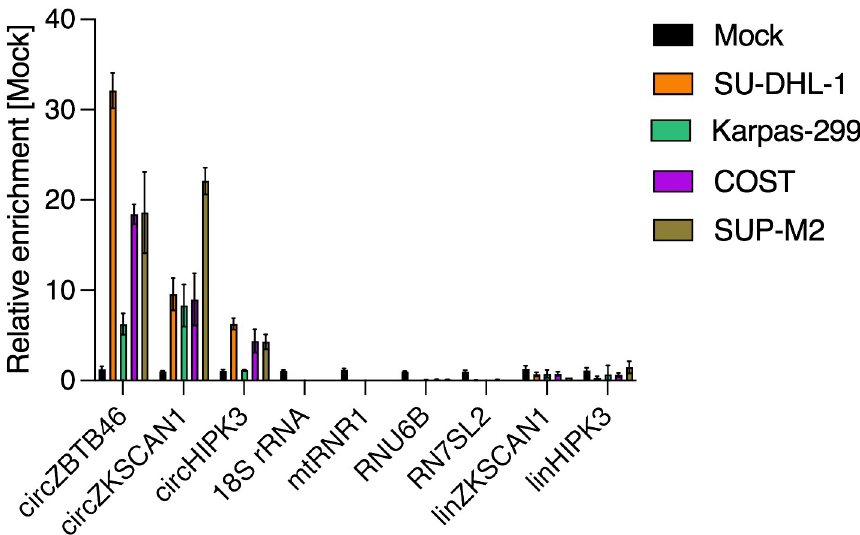
Fig 2. circRNAs get enriched by the library workflow. 4 different RNA samples from anaplastic large-cell lymphoma cell lines (SU-DHL-1, Karpas-299, COST and SUP-M2) were treated enzymatically to enrich for circRNAs as described in the protocol. The expression of circRNAs and unwanted transcripts (ribosomal RNA, 18S rRNA; mitochondrial RNA, mtRNR1; small-nucleolar RNA, RNU6B; signal recognition particle RNA, RN7SL2 and linear RNAs/mRNAs, linkZKSCAN1, linHIPK3) was analyzed by qRT-PCR and compared with an untreated Mock control.